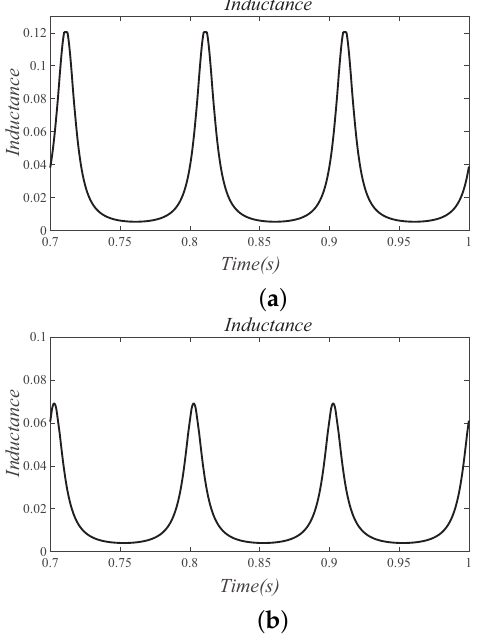
Figure 15. ( a ) Inductance of the machine with ( a ) alternate excitation mode and ( b ) bipole excita- tion